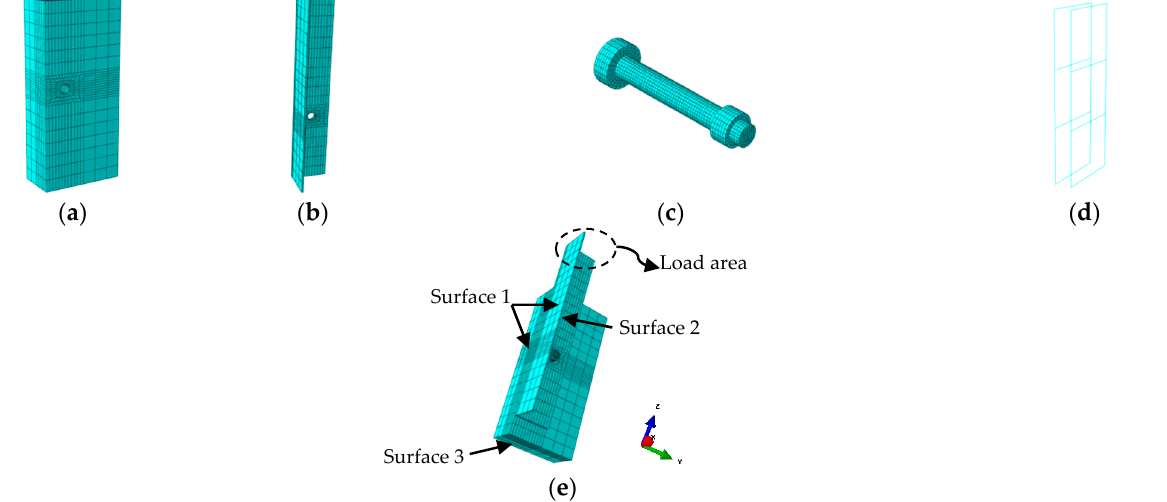
Figure 4. Mesh generation of the finite element model (FEM): ( a ) concrete plate; ( b ) steel beam; ( c ) bolted connector; ( d ) steel cage; ( e ) model.